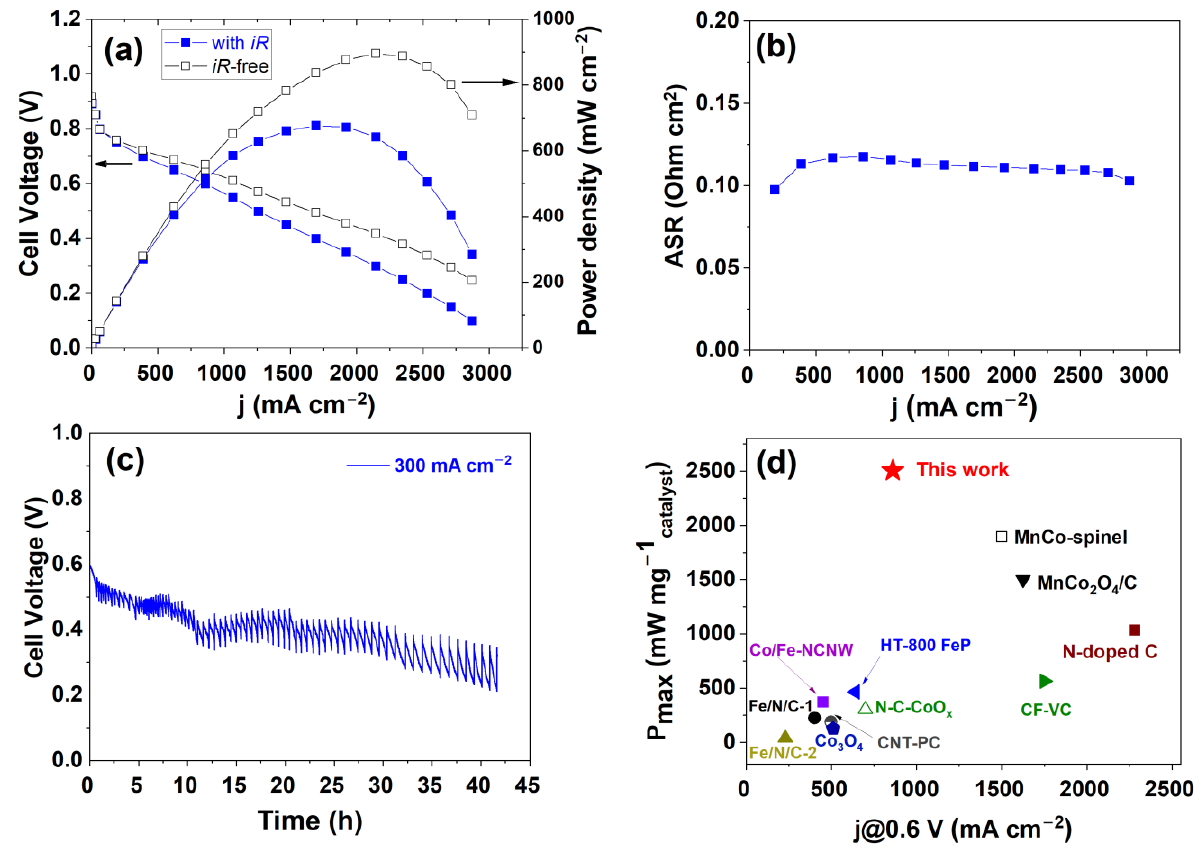
Figure 6. Single-cell H 2 -O 2 operando AEMFC fabricated using a CoO x -Fe 3 O 4 /N-rGO cathode and PtRu/C anode. The cell temperature was 80 °C, anode and cathode dew points of 73 and 75 °C were used, and anode and cathode gas flow rates were set to 1000 mL min −1 and pressurized to 1 barg on both sides. The anode and cathode catalyst loadings were 0.54 mg PtRu cm −2 and 0.27 mg CoOx - Fe3O4/N - rGO cm −2 , respectively. Standard and iR - free polarization curves ( a ), ASR vs. current density during standard polarization ( b ), AEMFC longevity test under a constant current density of 300 mA cm −2 with the same machine conditions as in plot ( a , c ), and comparison of PGM - free cathode AEMFC P max per catalyst mass vs. current density @ 0.6 V during cell polarization: Fe/N/C - 2 [40], Co3O4 [48], CNT/PC [39], Fe/N/C - 1 [38], N - CoO x [43], Co/Fe - NCNW [33], HT - 800 FeP [23], CF - VC [78], N - doped C [22], MnCo 2 O 4 /C [47], and MnCo - spinel [79] ( d ). For ( d ), the data values were estimated from the relevant literature.